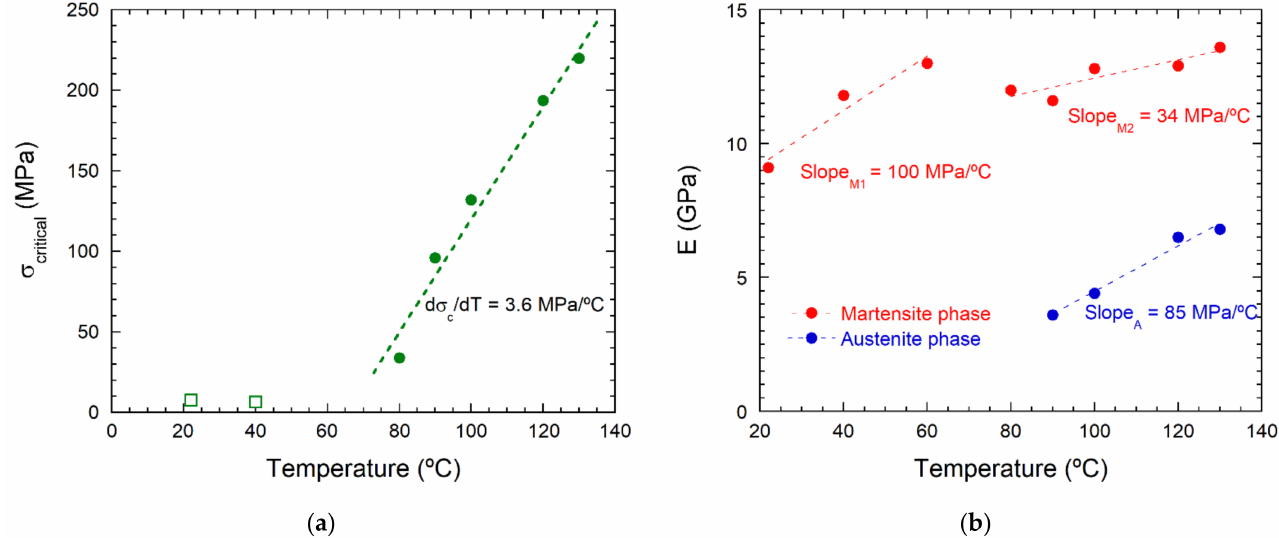
Figure 2. ( a ) Temperature dependence of the critical stress of the MT start (solid circles) and twinning stress (open squares). ( b ) Evolutions of Young’s moduli, E A and E M , with the temperature. All lines are the linear fits to the data